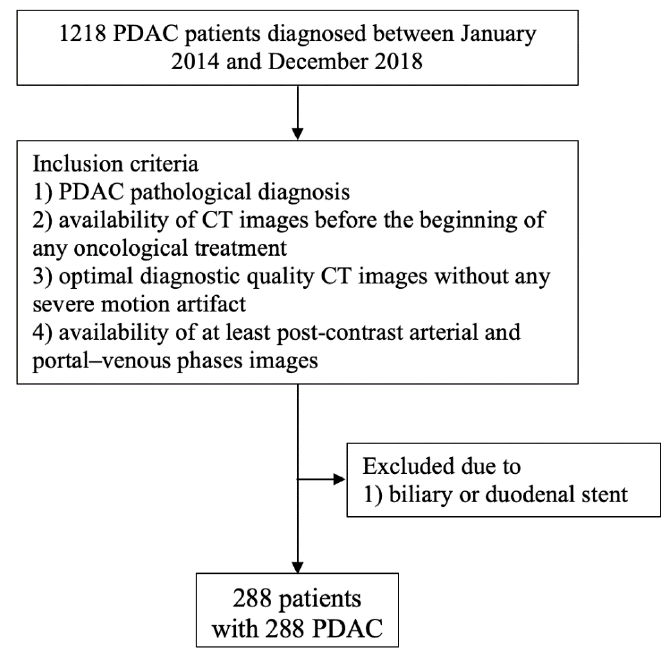
Figure 1. Flow chart showing patient selection criteria.